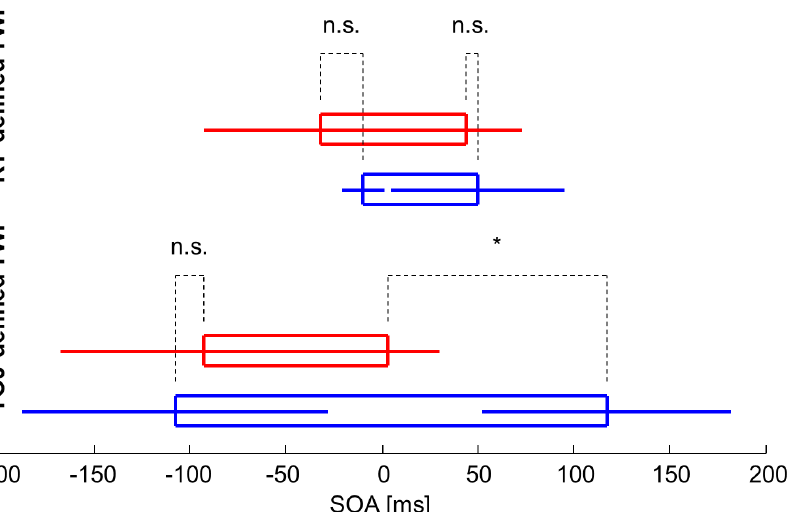
Figure 6. The reaction time- and temporal order judgment-defined temporal window of integration. Means and standard deviations of the boundaries of the temporal window of integration (TWI) defined by the reaction time (RT) and temporal order judgment (TOJ) tasks for the participants who displayed task demand-induced TWI malleability (red, n=5) and for those who did not (blue, n=6). n.s. not significant, *p , 0.05.